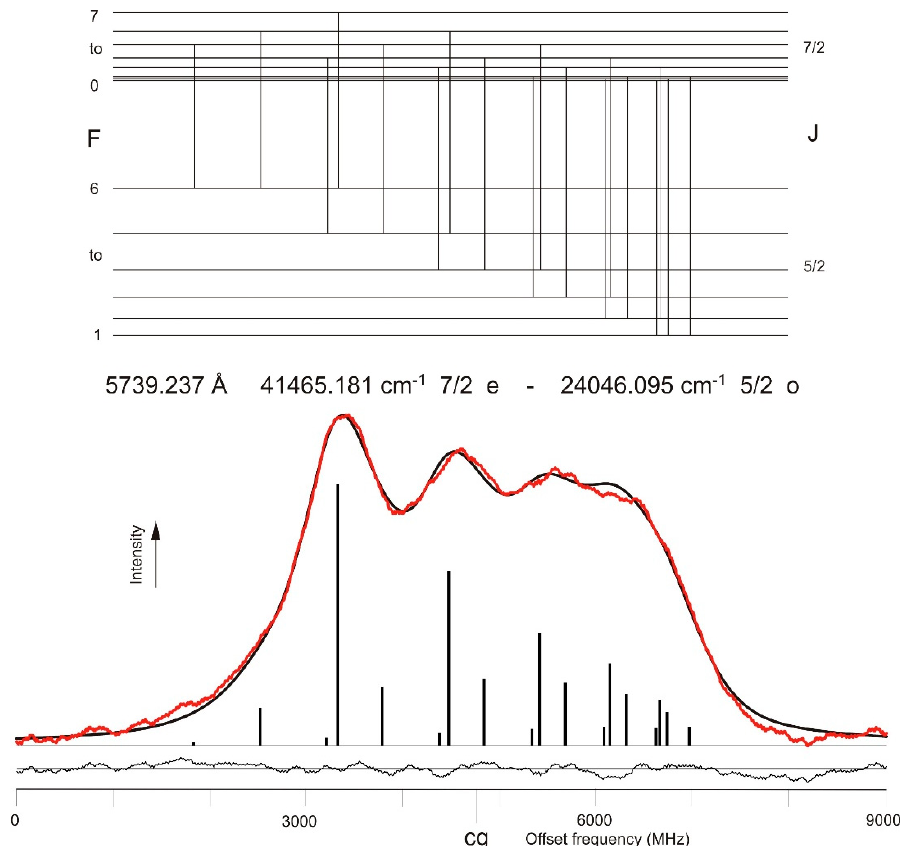
Figure 5. OG recorded hf pattern of the line at 5739.237 Å (transition between the new even level at 41,465.181 cm − 1 , J = 7/2, A = 116 MHz and a known odd lower level, 24,046.095 cm − 1 , J = 5/2, A = 325.8(17) MHz [12]), excited as confirmation of the existence of the newly found level. Red line: experiment; black line: fitted curve assuming a Voigt profile. The FWHM was fitted to be 900 MHz. Also shown is the hf level scheme and the position of the hf components and their intensities (theoretical ratios). The lower trace shows the residual between experimental and fitted curve. At this line a negative LIF signal at 4157 Å was observed, confirming that the lower level of this laser-excited transition is 24,046.095 cm − 1 .